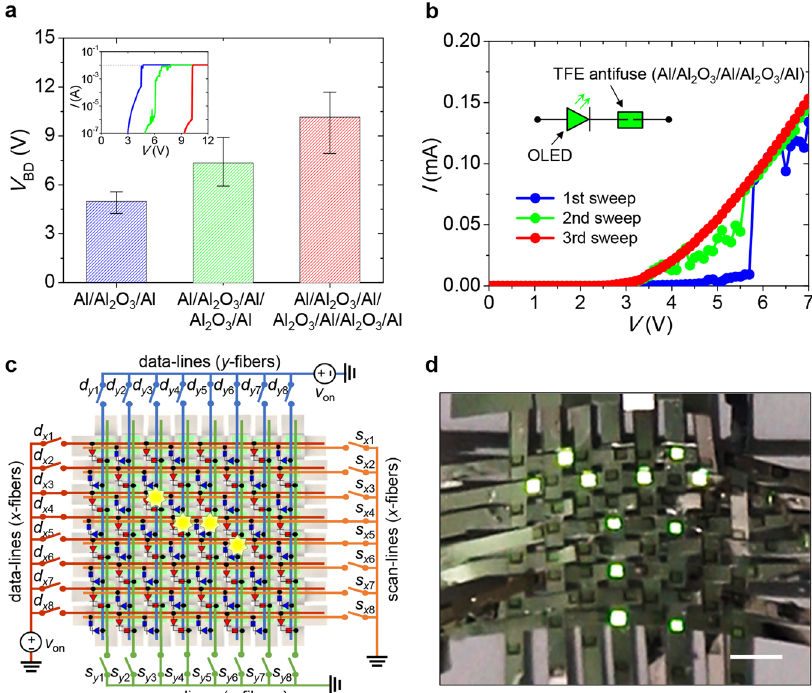
Fig. 3 Electrical properties of encapsulated OLED fi ber pixels and driving characteristics of woven OLED fi ber displays. a Measured breakdown voltages ( V BD ) of 5-nm Al 2 O 3 -based dielectric antifuses comprising single (Al/Al 2 O 3 /Al), double (Al/Al 2 O 3 /Al/Al 2 O 3 /Al), or triple (i.e., Al/Al 2 O 3 /Al/Al 2 O 3 /Al/Al 2 O 3 /Al) Al 2 O 3 layers (error bar: standard deviation). The inset indicates representative breakdown current ( I )-voltage ( V ) curves of these antifuses in logarithmic scale. b Measured I - V curves of an encapsulated OLED fi ber pixel with the antifuse of double Al 2 O 3 layers for the fi rst, second, and third voltage sweeps in the range of 0 ~ 7 V. c Illustration of the passive matrix addressing process for interlaced 8 × 8 OLED fi ber arrays, where the ITO/Cr data-lines ( d x 1 ~ d x 8 , d y 1 ~ d y 8 ) and the Cr/Ag scan-lines ( s x 1 ~ s x 8 , s y 1 ~ s y 8 ) of x - and y - fi bers are linked to external voltage source ( V on ) and ground, respectively. Here, 8 individual switches ( d x 3 , d x 4 , d y 5 , d y 6 , s x 4 , s x 5 , s y 3 , s y 4 ) are activated for concurrently turning on 4 pixels at (3, 3), (4, 4), (4, 5), and (5, 6). d Photograph of the 8 × 8 OLED fi ber display operated by the passive matrix addressing method (scale bar: 5